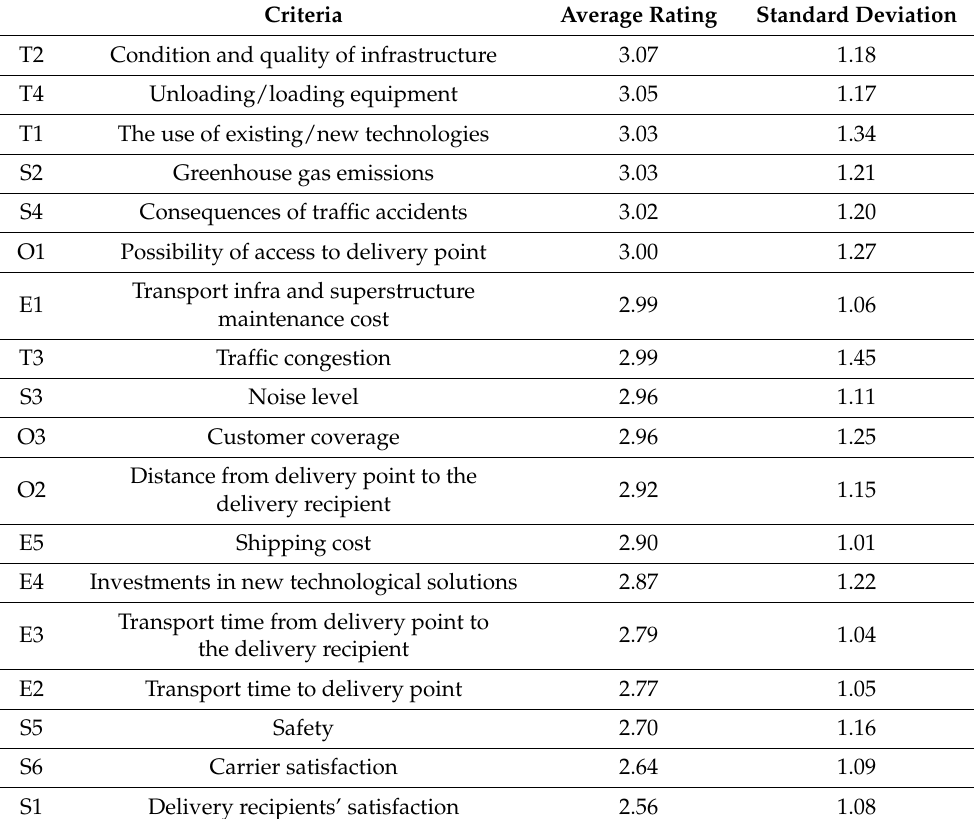
Table 2. Average ratings of the relevance of the criteria by all